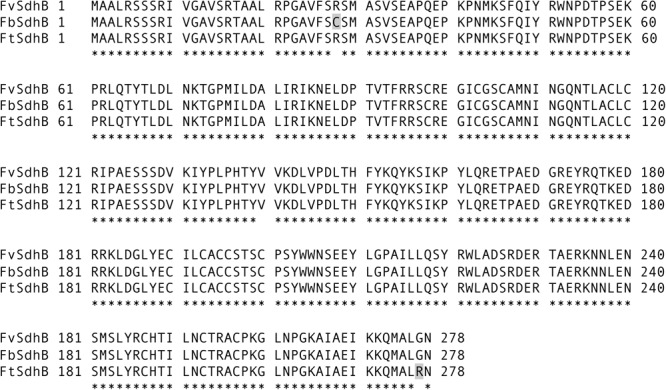
Alignment of the full length of SdhB amino acid sequences of F. brasiliense, F. virguliforme, and F. tucumaniae strains. FbSdhB, FvSdhB, and FtSdhB refer to SdhB amino acid sequence from F. brasiliense, F. virguliforme, and F. tucumaniae, respectively. The shaded letters indicate difference at amino acid position 28 in F. brasiliense from other species and 277 in F. tucumaniae from other species. Asterisks indicate identical amino acids among the strains compared.